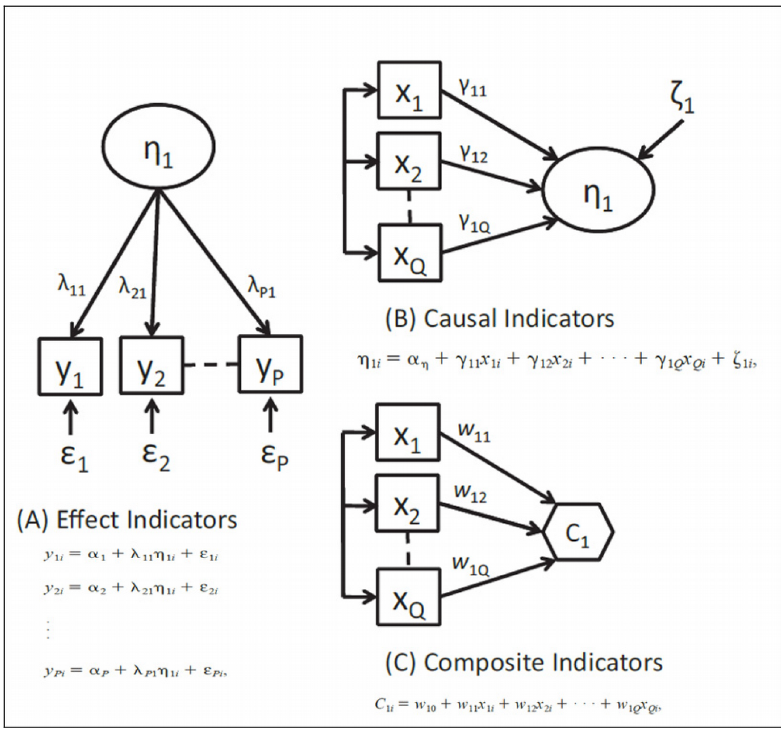
Figure 6. The three types of constructs (Bollen & Bauldry,